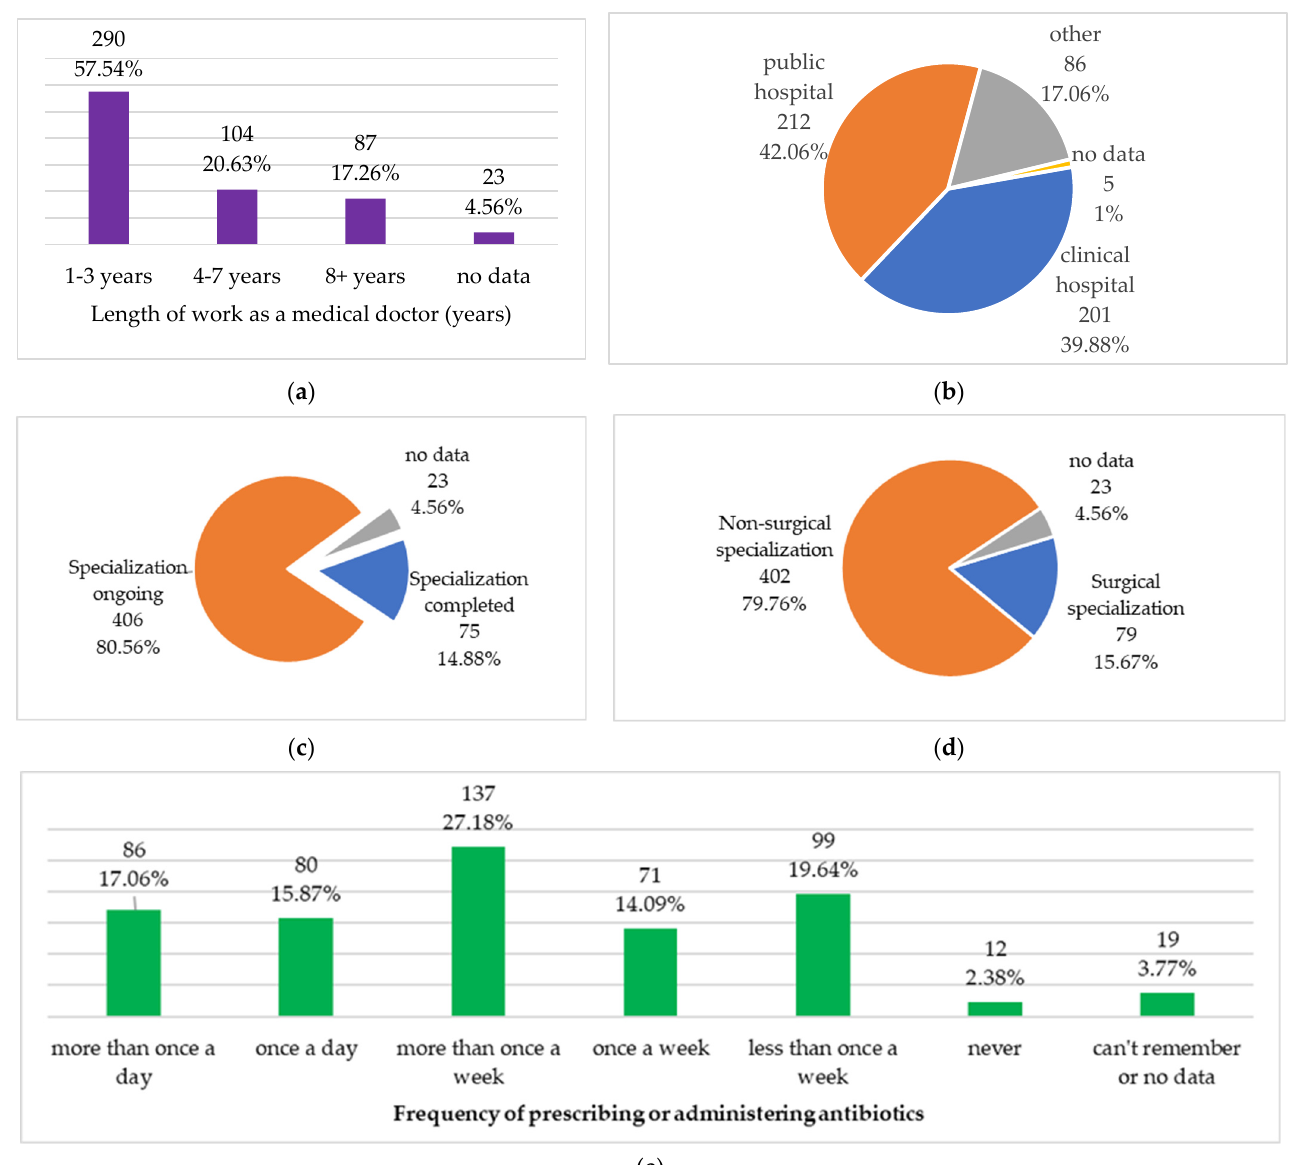
Figure 2. Professional characteristics of the study group: ( a ) length of work as a medical doctor; ( b ) main workplace; ( c ) specialization status; ( d ) type of specialization; ( e ) frequency of prescribing or administering antibiotics.